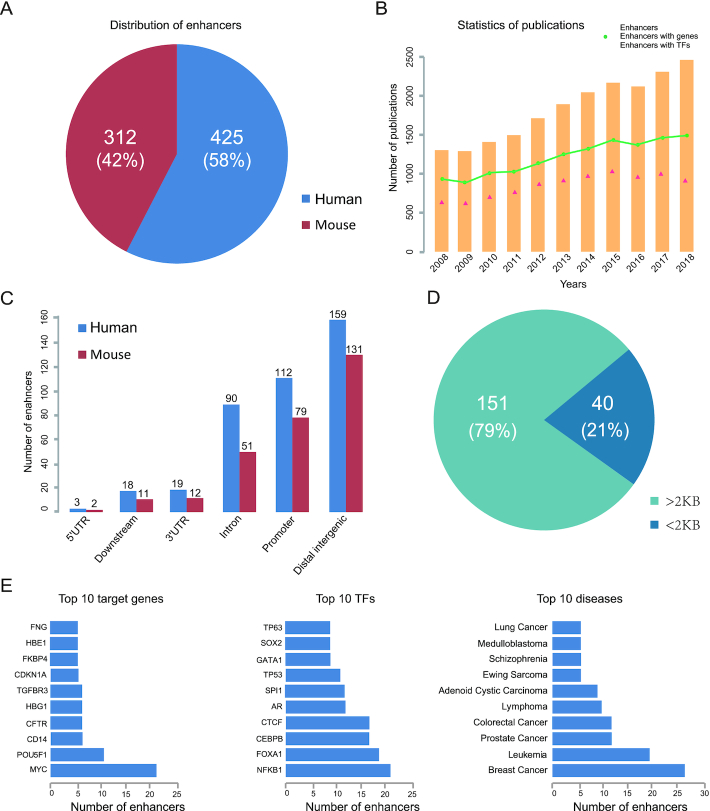
Statistics of enhancers in ENdb. (A) The distribution of enhancers for human and mouse. (B) The annual number of publications on enhancers and their related information each year. (C) The distribution of enhancers in genomic elements. (D) The distribution of enhancers in the promoter and distant regions. (E)The number of enhancers associated with the top 10 target genes (left), TFs (middle) and diseases (right).